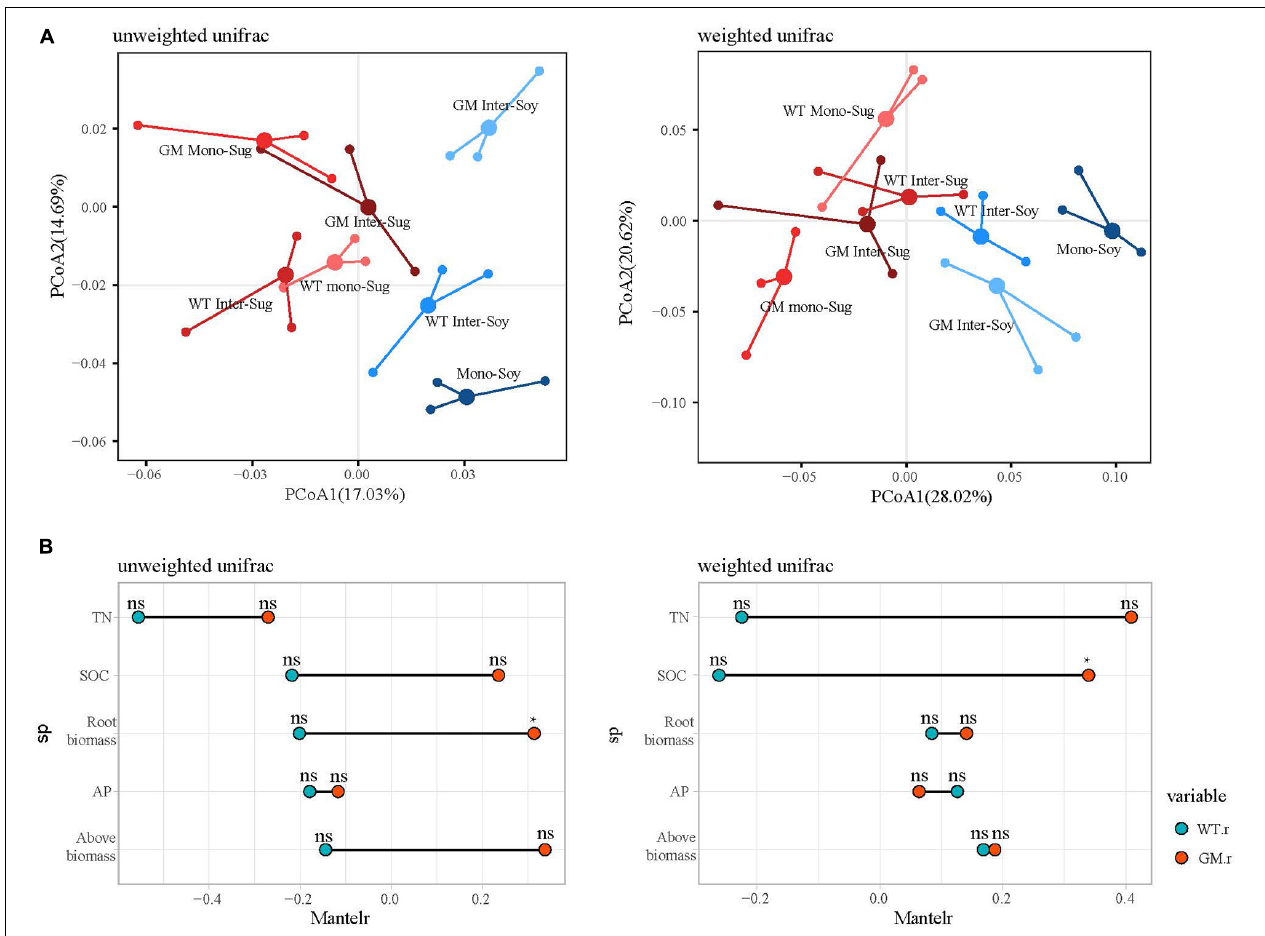
FIGURE 3 | (A) Principal coordinate analysis (PCOAS) based on the Unifrac distance matrix indicated differences in bacterial beta diversity under different planting modes. (B) Mantel test compared the relative differences of soil nutrients under different planting modes. P > 0.05(NS); P <